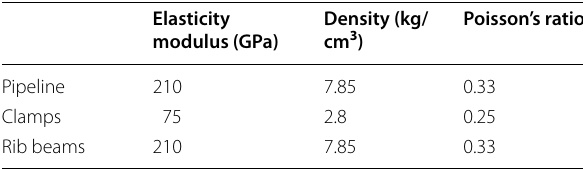
Table 2 Structural material